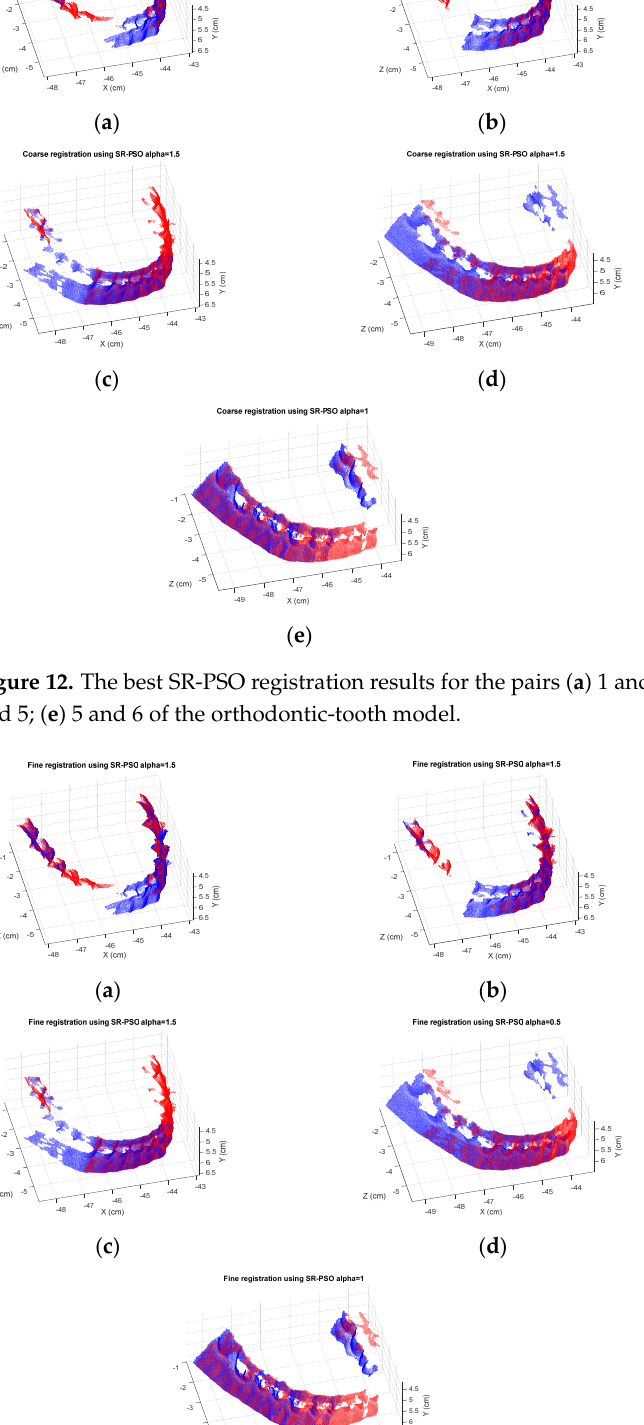
Figure 13. The best SR-PSO with ICP registration results for the pairs ( a ) 1 and 2; ( b ) 2 and 3; ( c ) 3 and 4; ( d ) 4 and 5; ( e ) 5 and 6 of the orthodontic-tooth model.